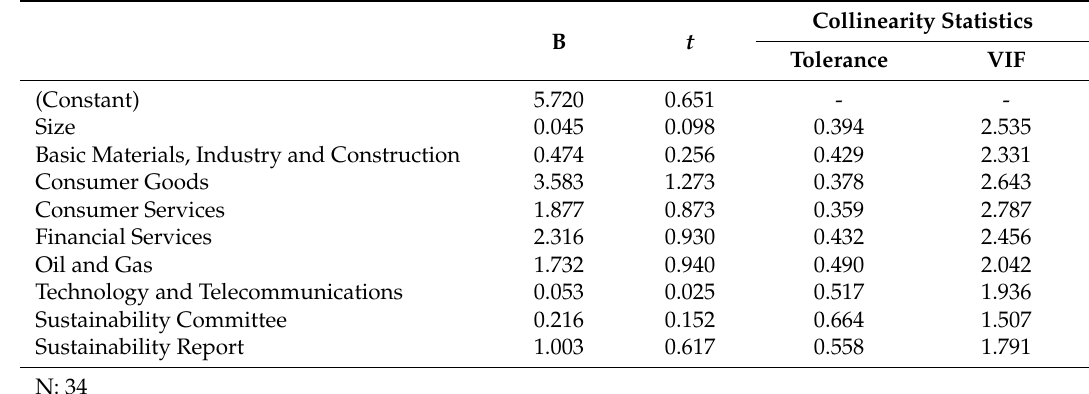
Table 13. Anti-corruption/Bribery Matters Index as Dependent